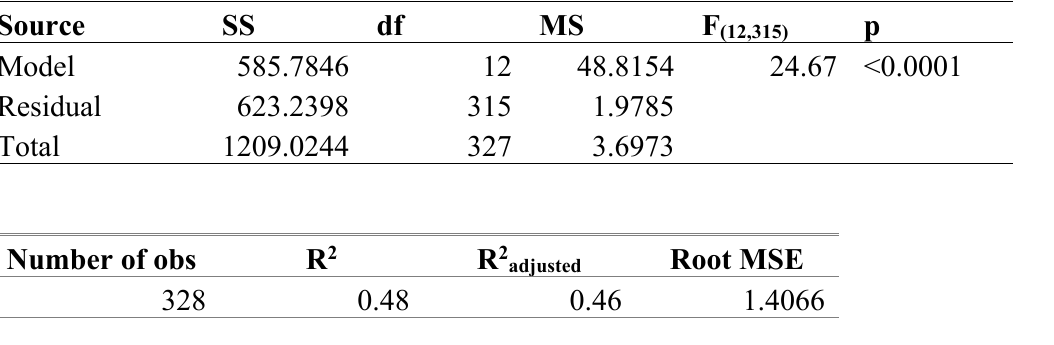
Table A1.4. Regression results for trust ecology measures including salience